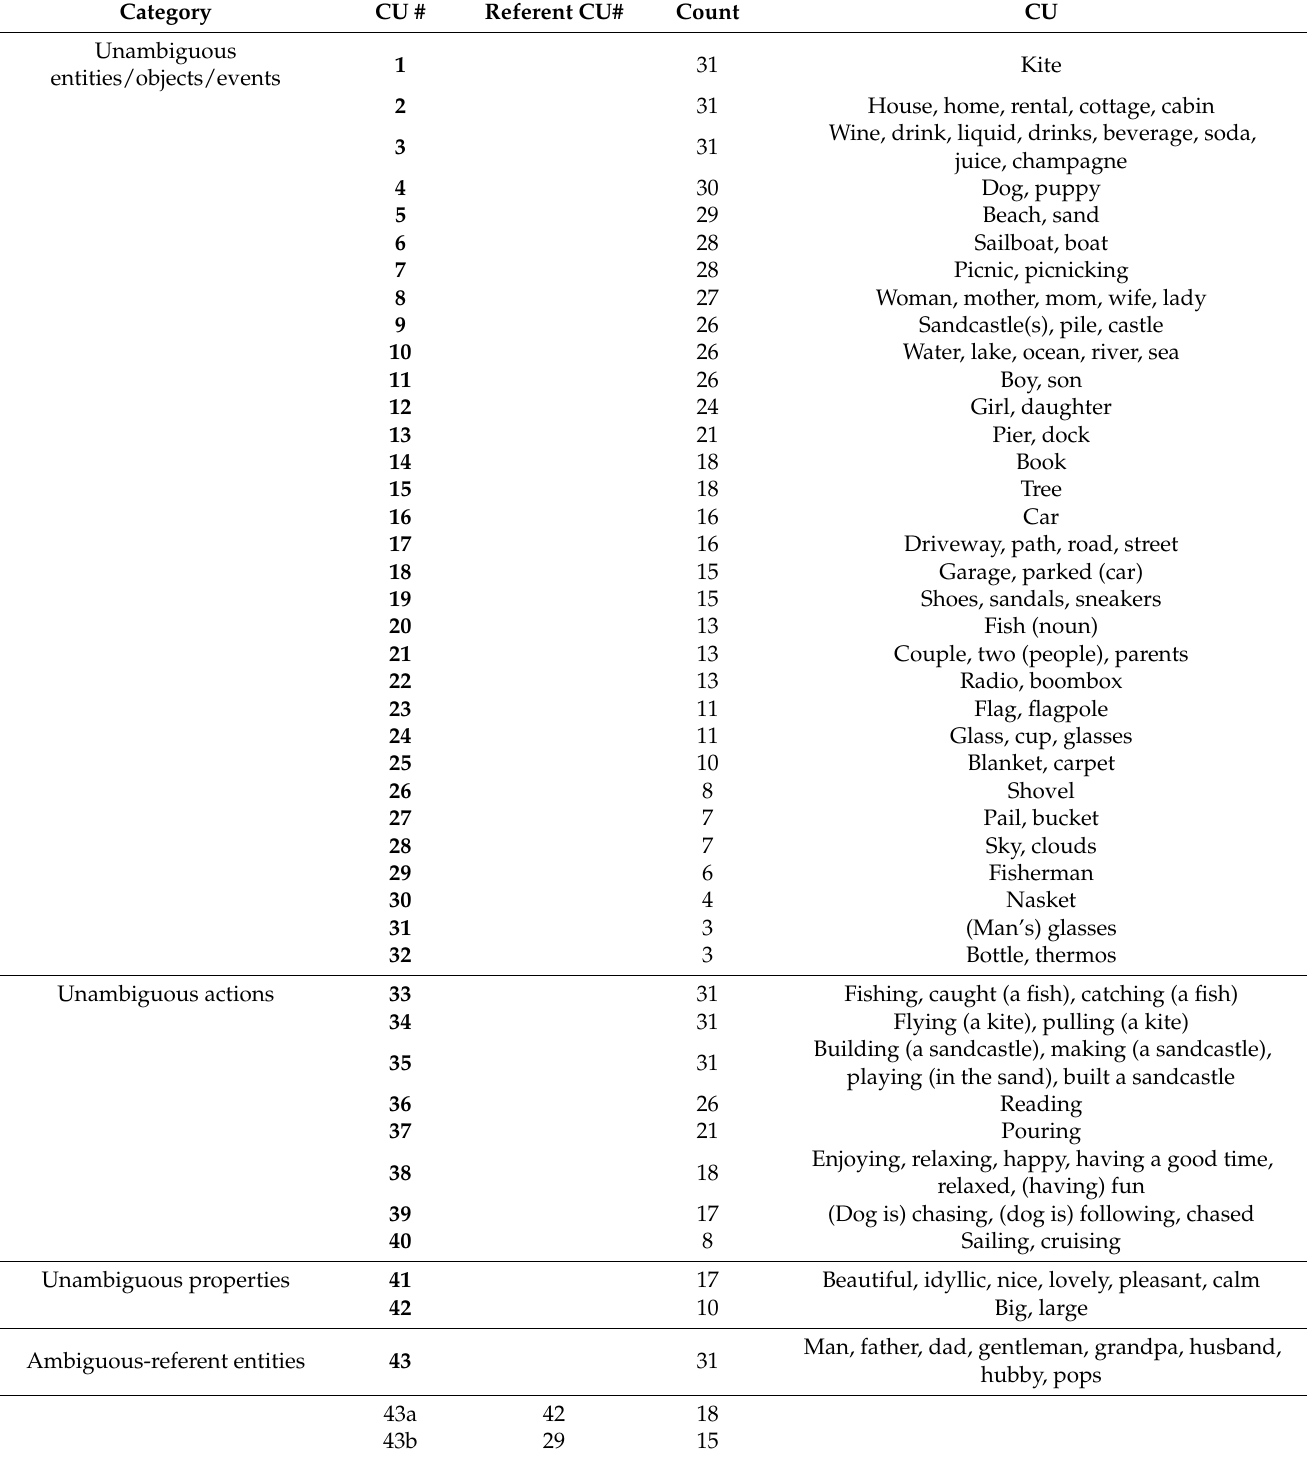
Table 2. The complete set of 64 content units (CUs) identified in our healthy control sample ( n = 31) based on Berube et al.’s (2019) methods [21]. The number of healthy control participants who produced a given CU in a speech sample is indicated in the “count” column. The unique referents for ambiguous CUs are represented in the “referent CU#” column, designating the agents, actions, and properties that at least three healthy control participants referred to by naming a particular